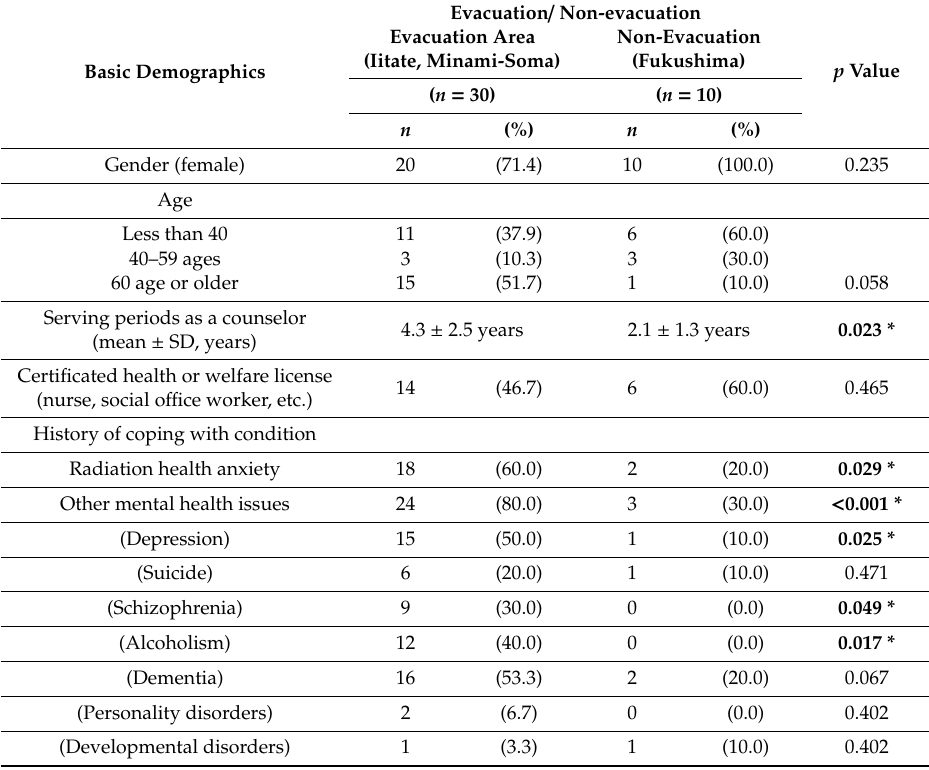
Table 1. Basic demographics of the subjects who participated in the survey of gatekeeper training program needs among livelihood support